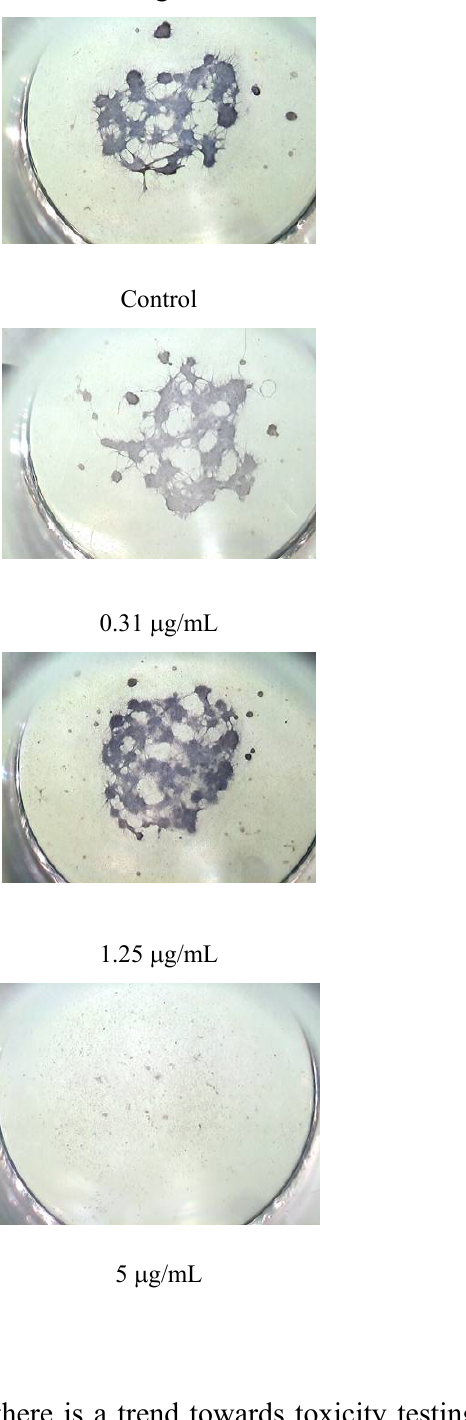
Figure 3. Images of midbrain micromass cultures, exposed for 5 days to different concentrations of OTA. Neurospheres were stained with haematoxylin (16 × magnification). After exposure to 2.5 µg/mL neurospheres were smaller and more numerous, after two highest concentrations no differentiated cells were